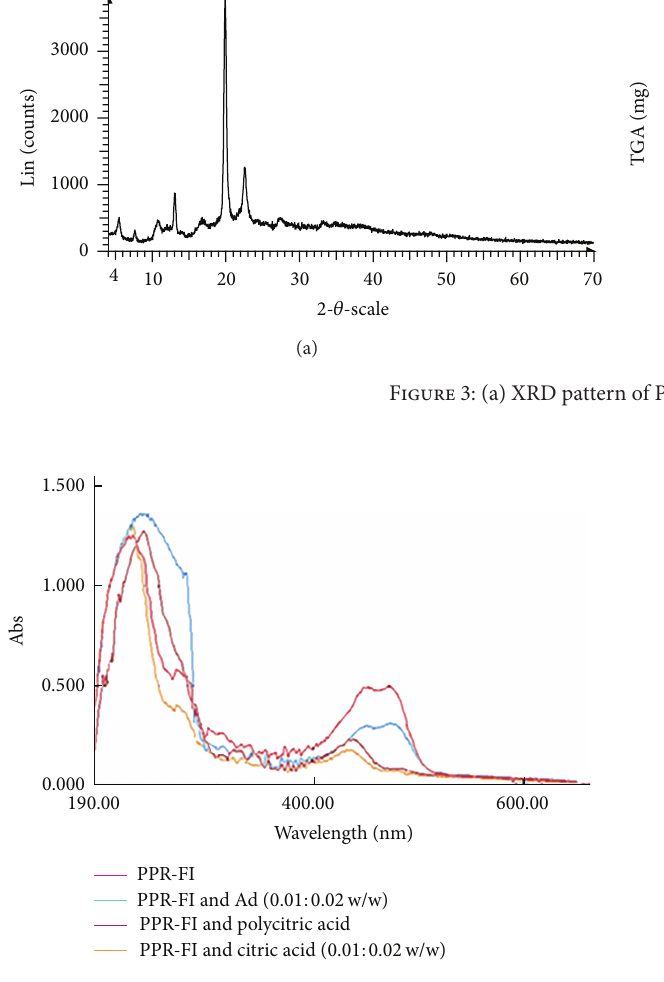
Figure 4: UV-Vis spectra of PPR-Fl, and this system capped by adenine, citric acid, and polycitric acid in PBS buffer and at room temperature.